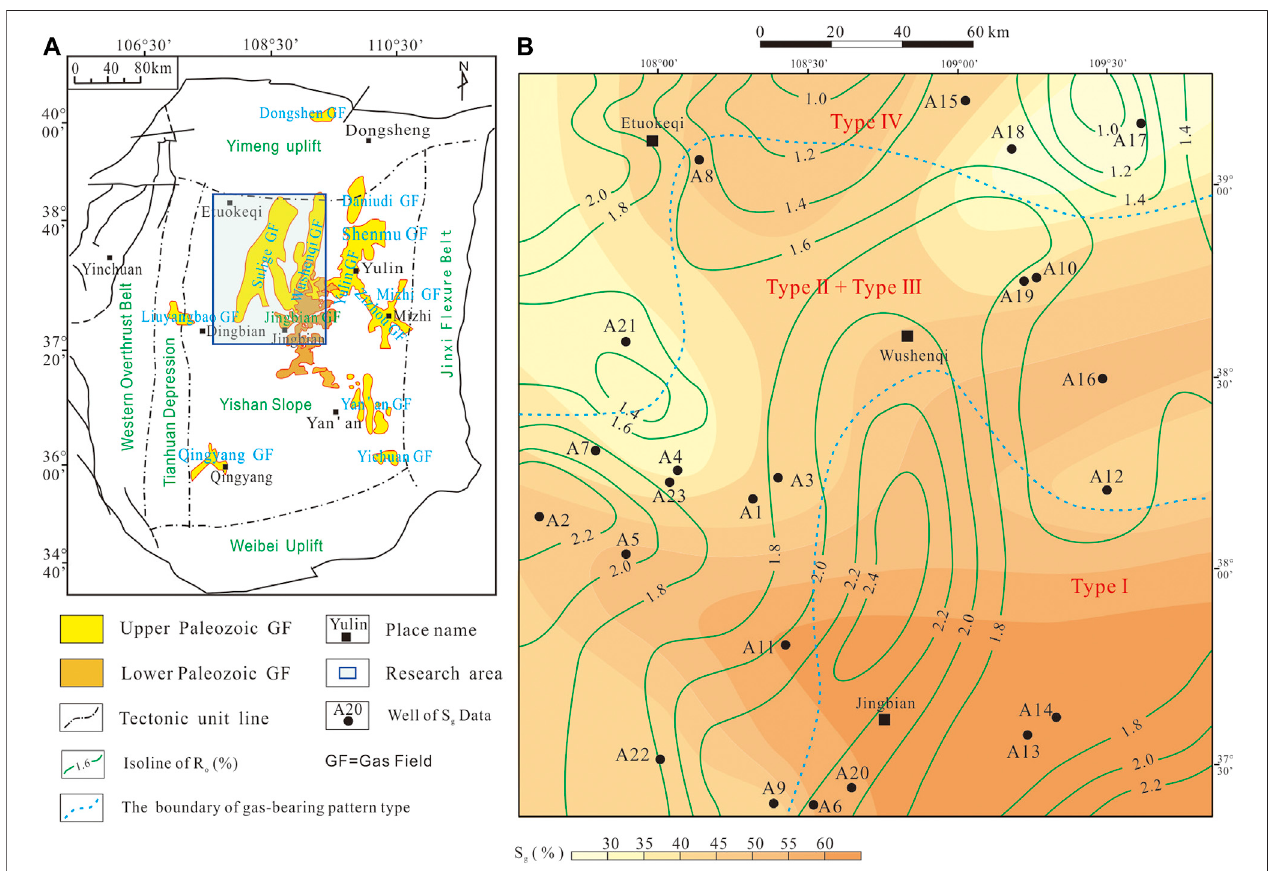
FIGURE 1 | (A) Location of SGF (blue box), with tectonic units of Ordos Basin shown. Yellow areas mark Upper Paleozoic gas fi elds, and brown marks Lower Paleozoic gas fi elds. (B) Contour map of well maximum sandstone gas saturation of Permian He8 Member, where green line is isoline of R o (%) and blue is boundary of gas-bearing pattern type as shown in Table 1